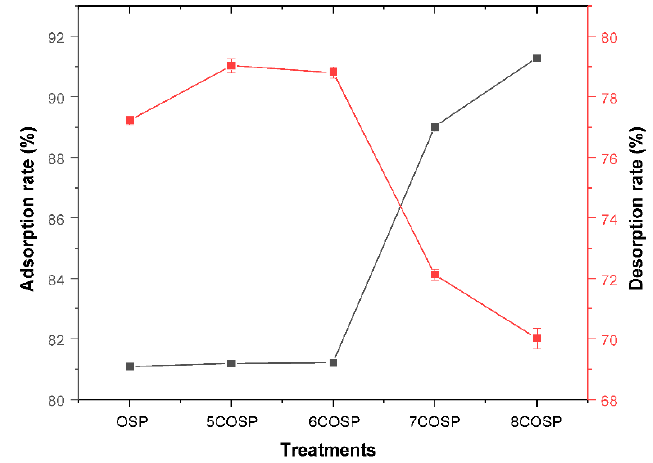
Figure 5. Urea adsorption and release rates under different treatments. OSP: 0.2 wt.% OSP; 5–8COSP: 0.2 wt.% OSP calcined at various temperatures; particle size of the OSP and four COSPs = 0.15 mm.